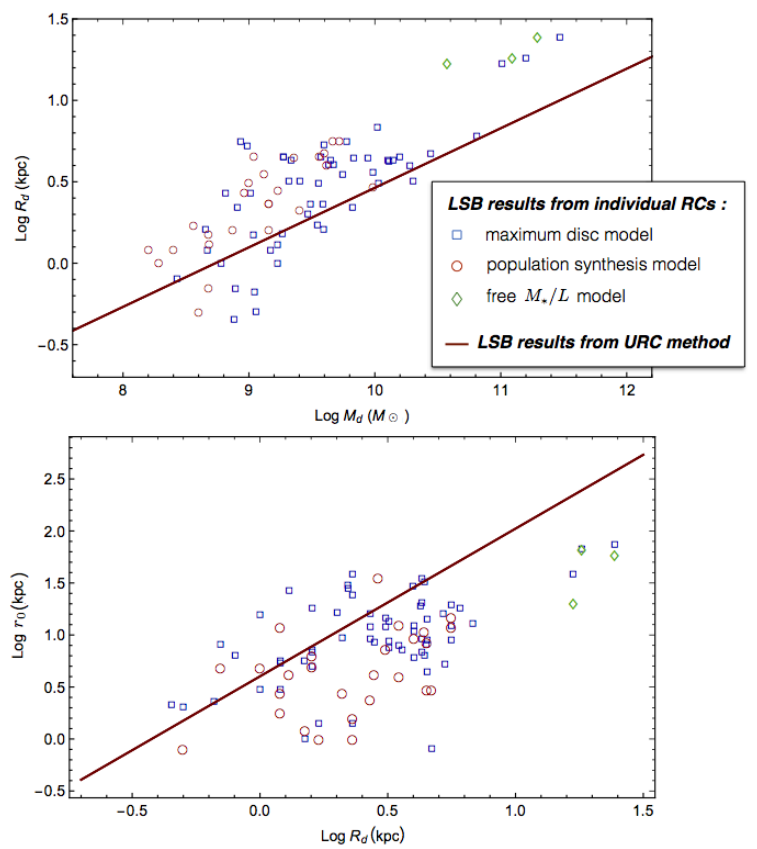
Figure 11. Structural properties of LSBs obtained by best-fitting individual RCs. ( upper panel): stellar disc scale length vs. mass of the stellar disc. ( lower panel): halo core radii vs. the stellar disc scale lengths. Different symbols and the line play as in the inset [38]. Image reproduced from